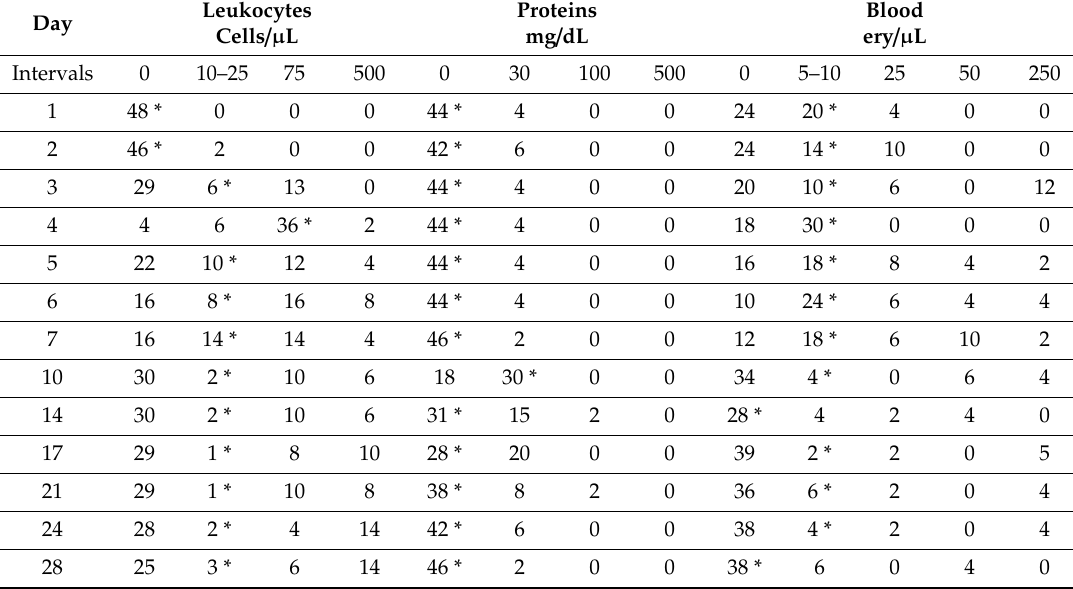
Table 2. Dipstick parameters recorded as intervals showing positive reaction at any time point during the study (leukocytes, proteins, blood) in the 48 Great Dane puppies from birth to 28 days of age. The number of puppies in each dipstick value-corresponding category is reported for each study